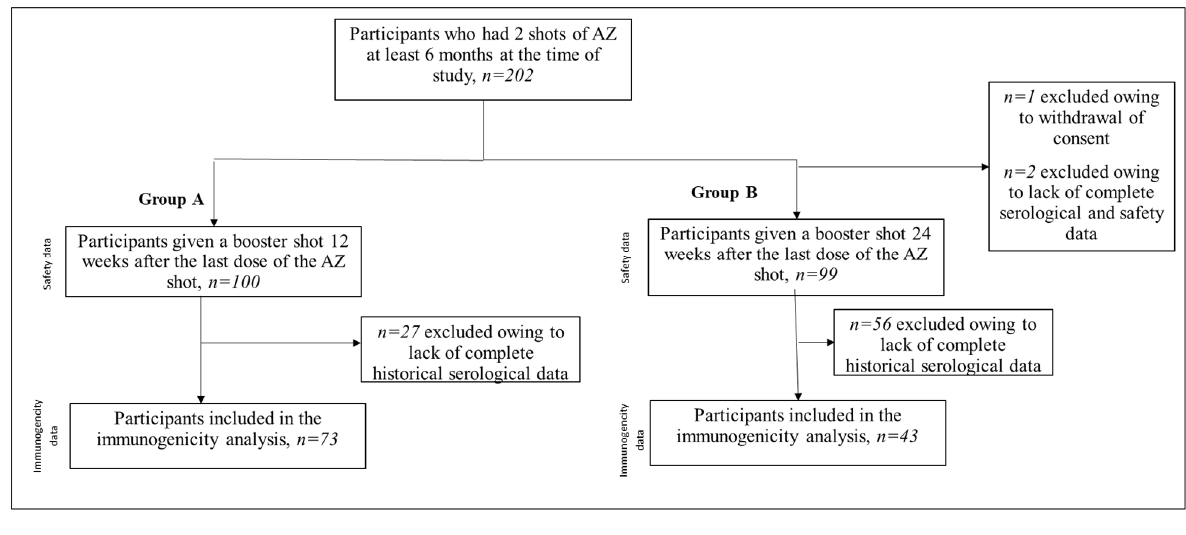
Figure 1. Study design and flowchart.